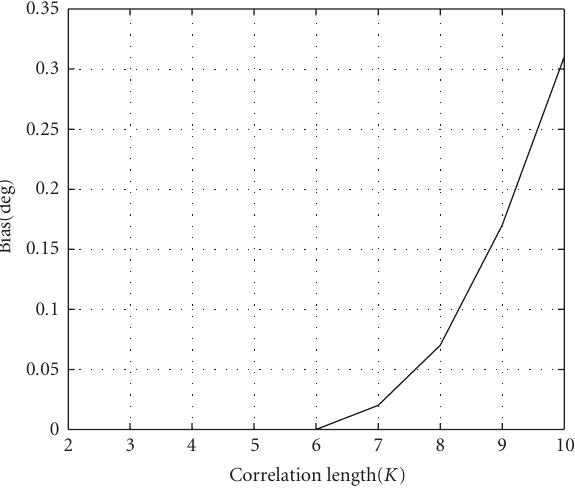
Figure 11: Localization of the three sources at 5 ◦ , 15 ◦ , and 25 ◦ without and with noise preprocessing for K = 3 and K = 5.